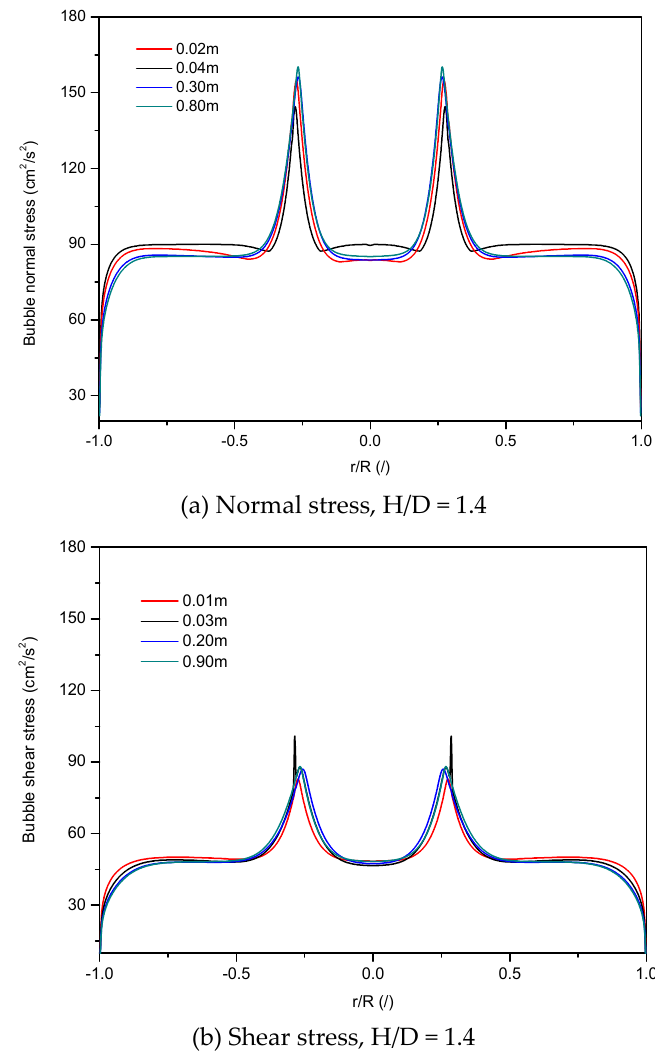
Figure 5. Distributions of bubble normal and shear stresses using two jetting holes (rjet/R = ±0.36), H/D = 1.4.